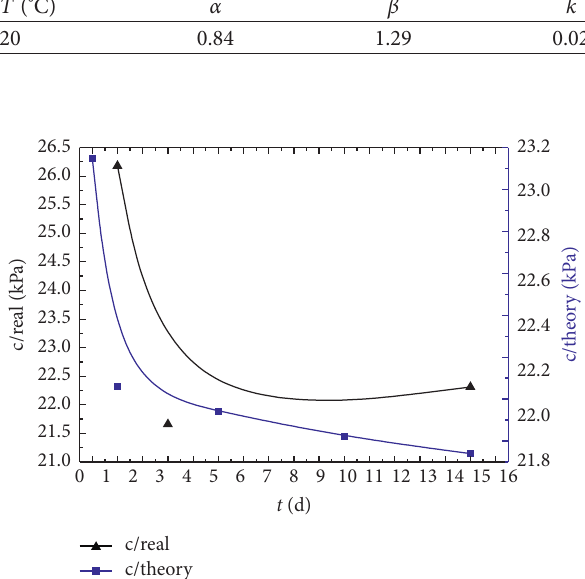
Figure 5: Comparison between theoretical and measured values of the cohesive force under acidic